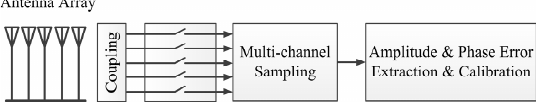
Figure 9. Calibration section of the WIOBSS-AA.